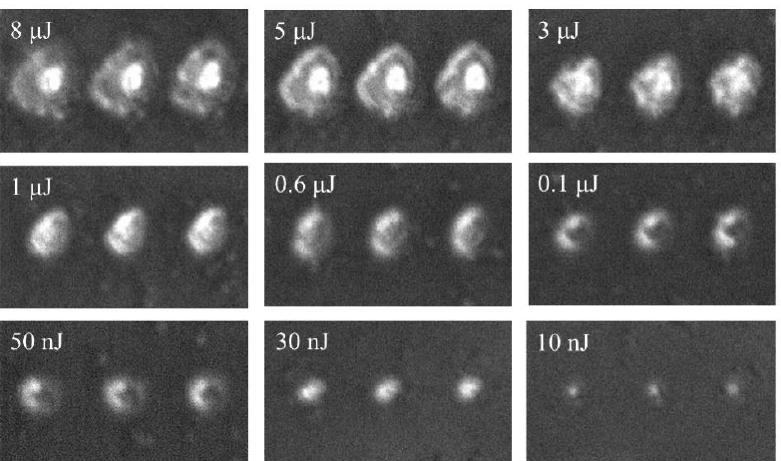
Figure 5. Phase contrast image of V 2 O 5 after irradiated by ultrafast laser with different pulse energy. The focal beam waist is 697